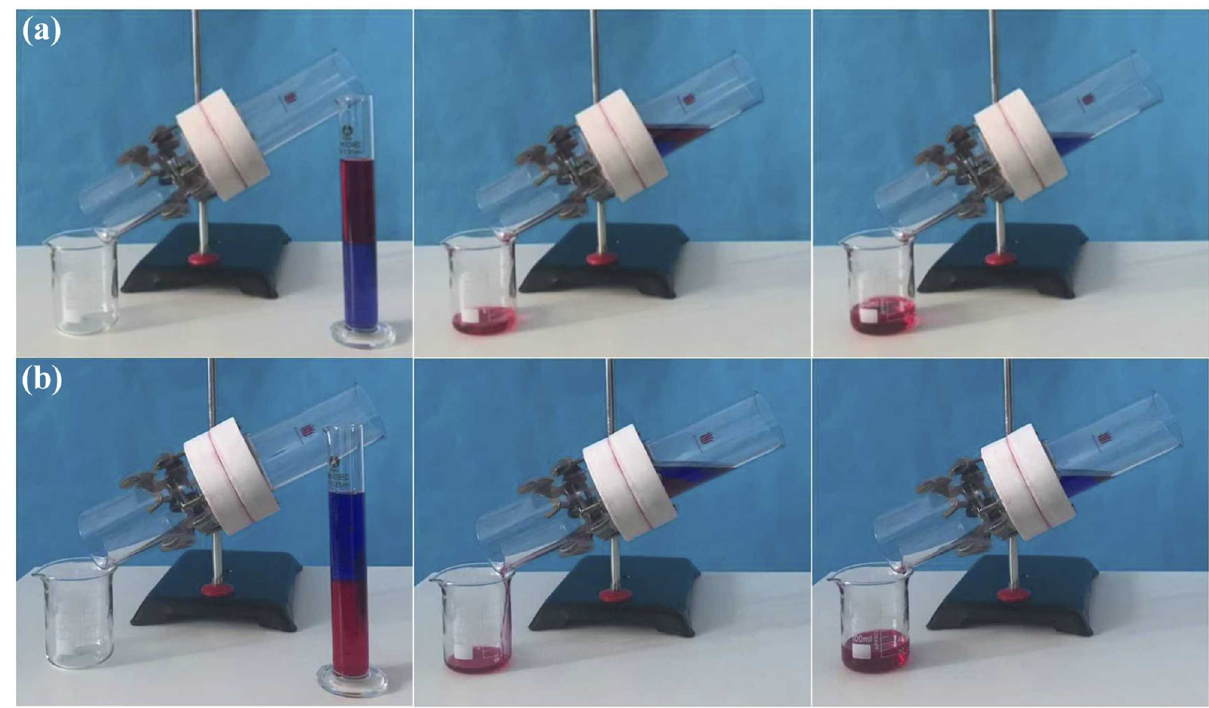
Figure 4: Oil – water separation using PBFF/Co ( OH ) 2 /POTS, the oil phase and water phase were dyed red and blue, respectively: ( a ) n - octane and water and ( b ) chloroform and water [ 26 ]